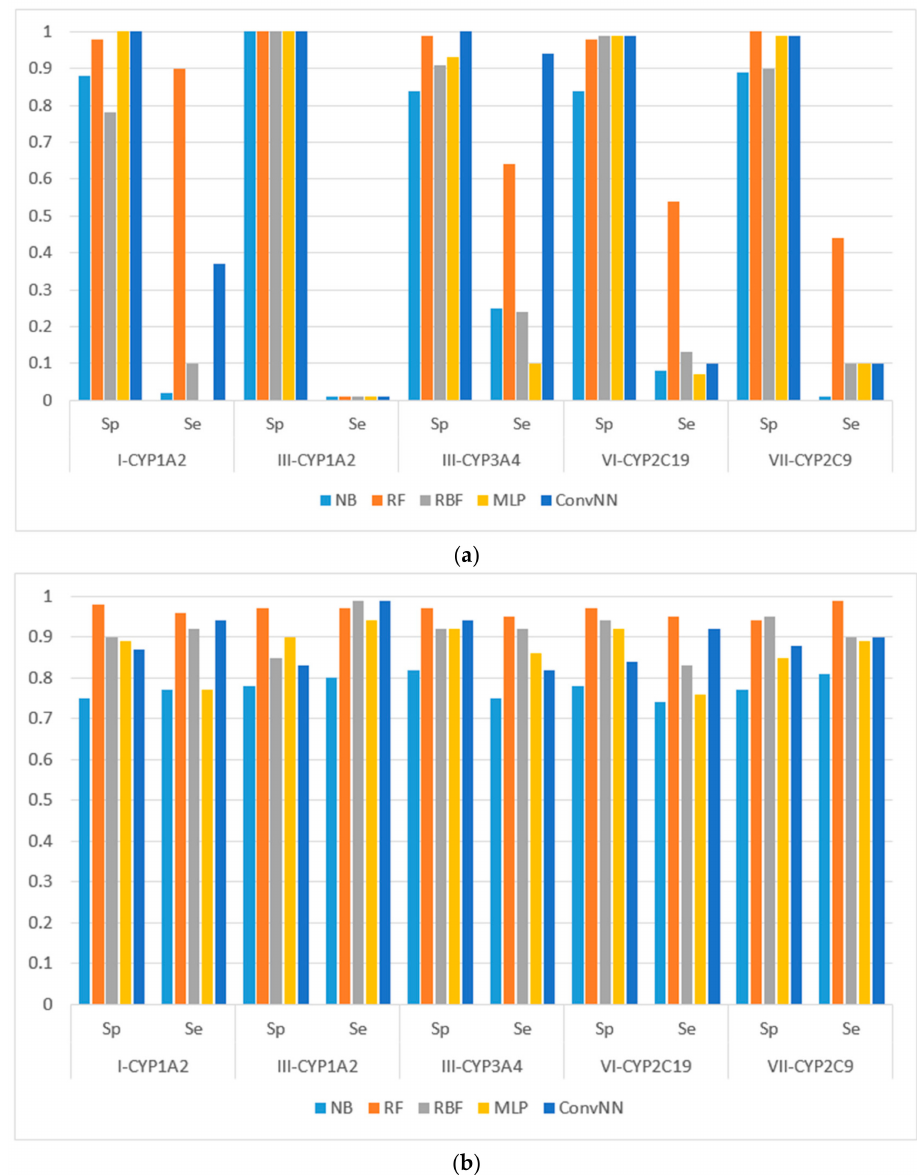
Figure 2. Sensitivity (Sp) and specificity (Se) of the classification models for SOM predictions of the datasets compiled according to the type of both metabolizing reaction and enzymes: ( a ) datasets before balancing; and ( b ) balanced datasets. X-axis: Roman numerals correspond to the following reaction types: I-CYP1A2: CYP1A2-aliphatic hydroxylation; III-CYP1A2: CYP1A2- C -oxidation; III-CYP3A4: CYP3A4- C -oxidation; VI-CYP2C19: CYP2C19- O -dealkylation; VII-CYP2C9: CYP2C9- S -oxidation. Machine learning algorithms: RF: random forest; RBF: radial basis function network; MLP: multilayer perceptron; Conv. NN: convolution neural network; AUC: area under the received operating characteristic curve. Y-axis: Sp = TN/(TN + FP), Se = TP/(TP + FN), TP is the number of true positives, FP is the number of false positives, TN is the number of true negatives, and FN is the number of false